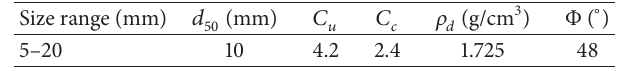
Table 1: Physical properties of crushed stones.